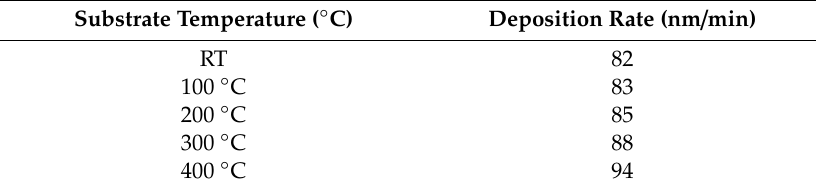
Table 1. Deposition rate at different substrate temperature.